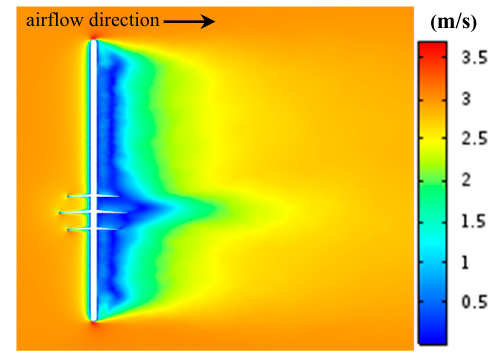
Figure 3. The contour map of airflow velocity in the insulator axial section.